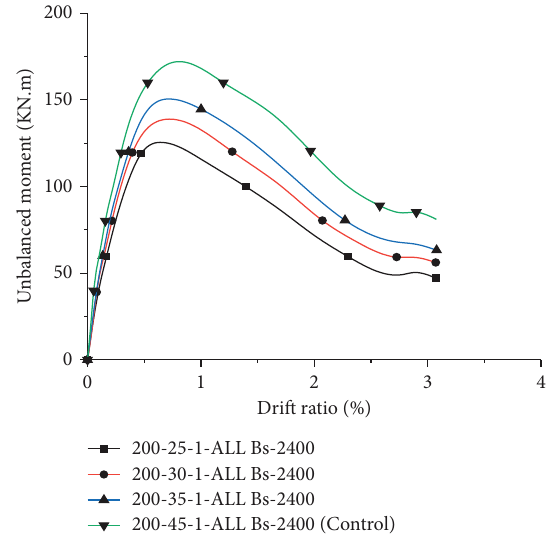
Figure 36: Efect of concrete grade on unbalanced moment drift